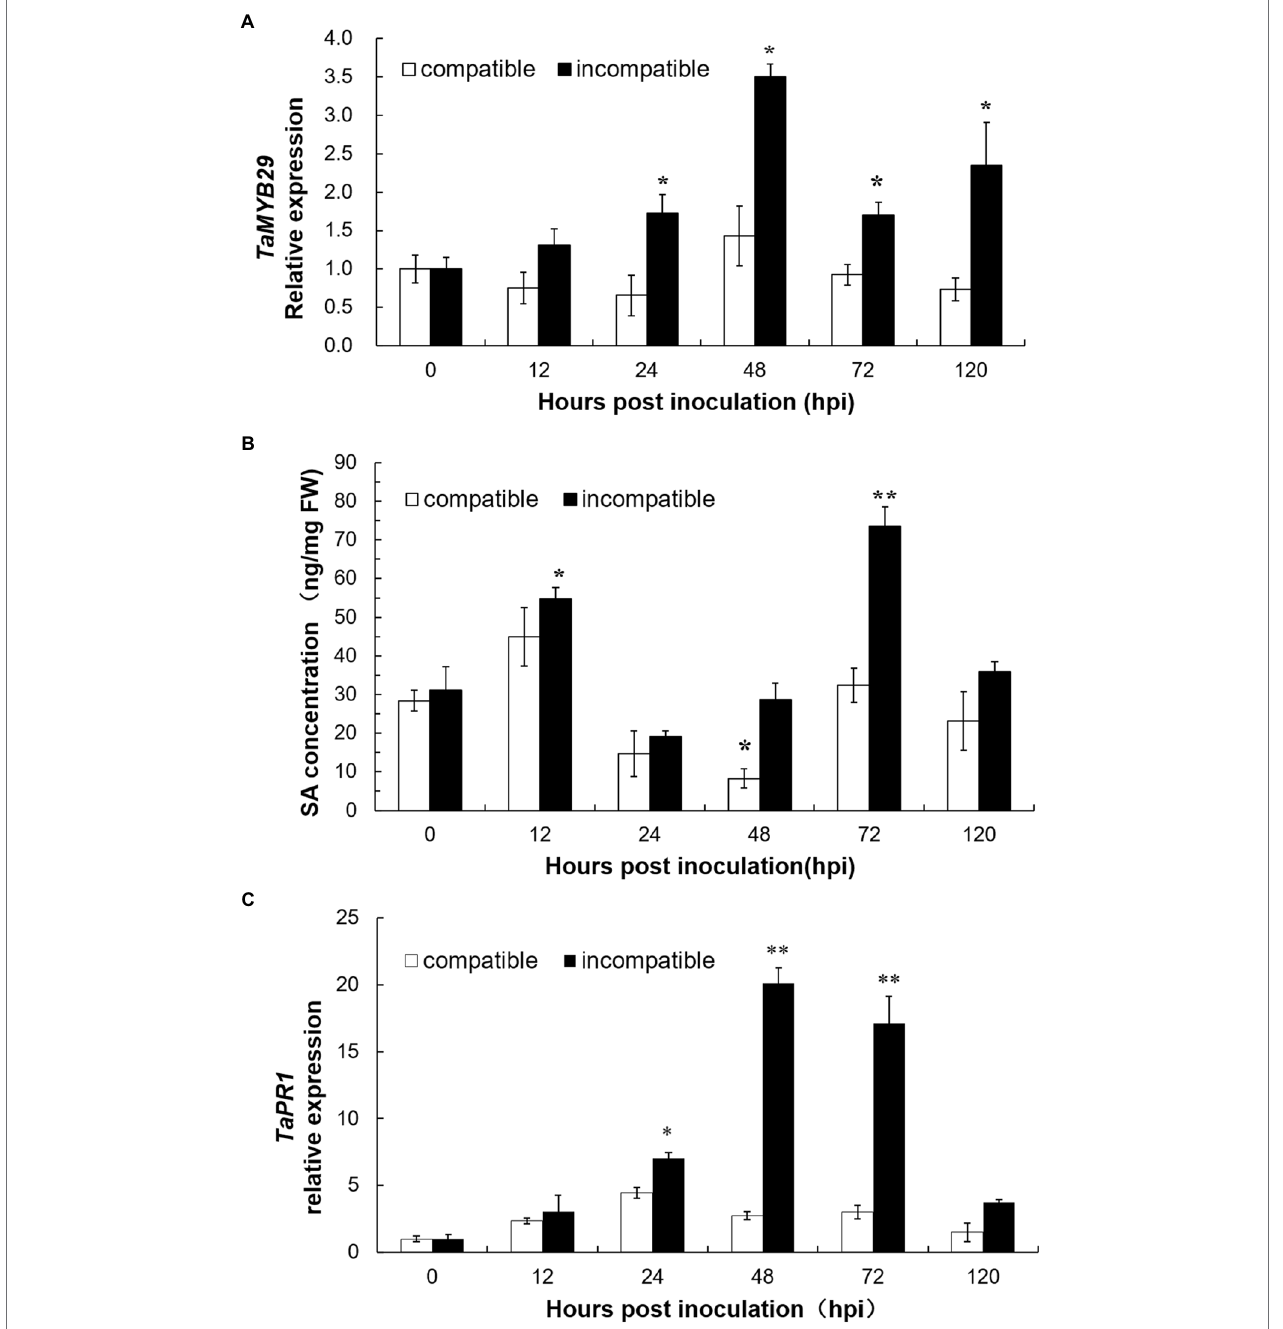
FIGURE 5 | The expression profiles of TaMYB29 (A) and TaPR1 gene expression (C) and salicylic acid (SA) concentration (B) in AvS and AvS+ Yr10 wheat leaves during the time course of stripe rust infection. The leaves were sampled at 0, 12, 24, 48, 72, and 120 h post-inoculation (hpi) with three biological experiments replicates. Error bars represent standard deviation among three biological replicates. Student’s t -tests were used to for the statistical analyses and the asterisks ( ∗ ) and ( ∗∗ ) indicate a significant difference between the particular time point and 0 hpi with a value of p < 0.05 and